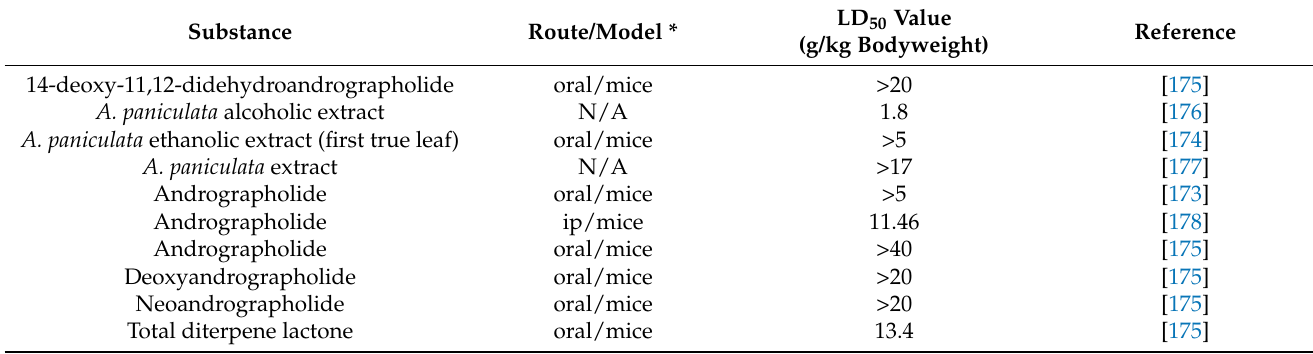
Table 2. The median lethal dose (LD 50 ) data of Andrographis paniculata extract and its